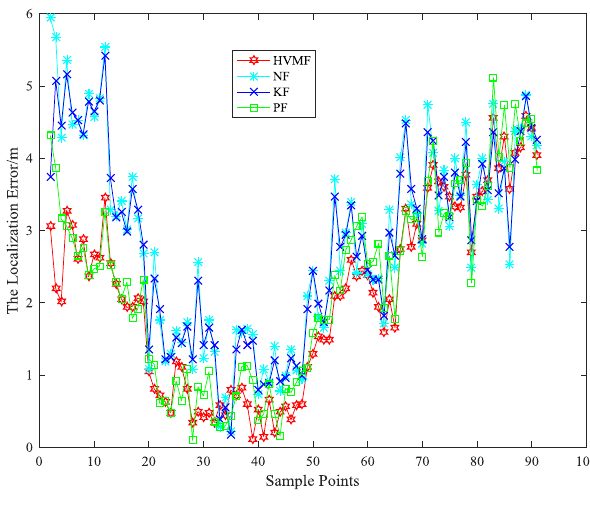
Figure 14. The localization error in each sample point.